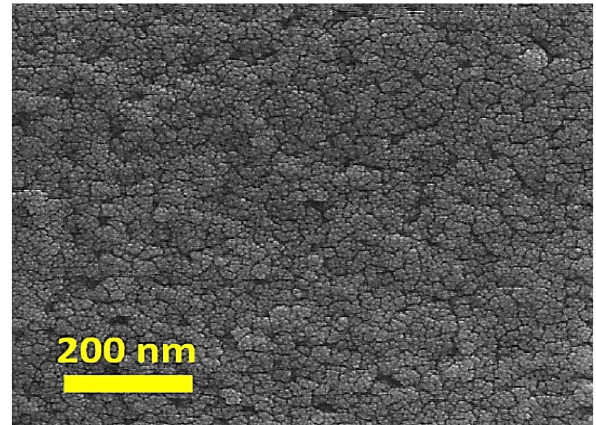
Figure 2. FESEM images of In 2 S 3 layers prepared by spray method at 250 ℃ .